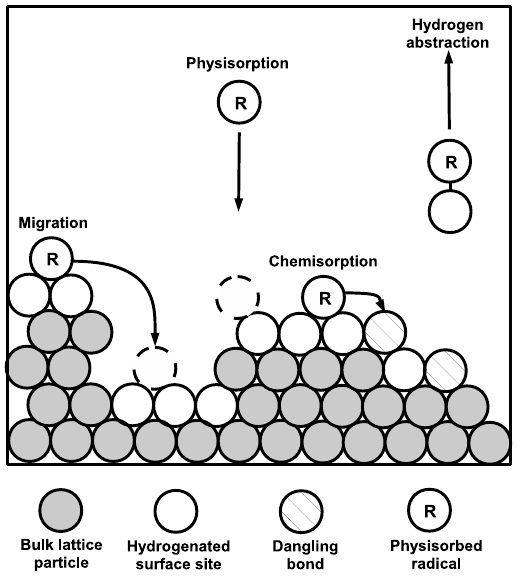
Figure 8. Triangular lattice representation showing four microscopic processes. Processes from left to right: migration, physisorption, chemisorption, and hydrogen abstraction.